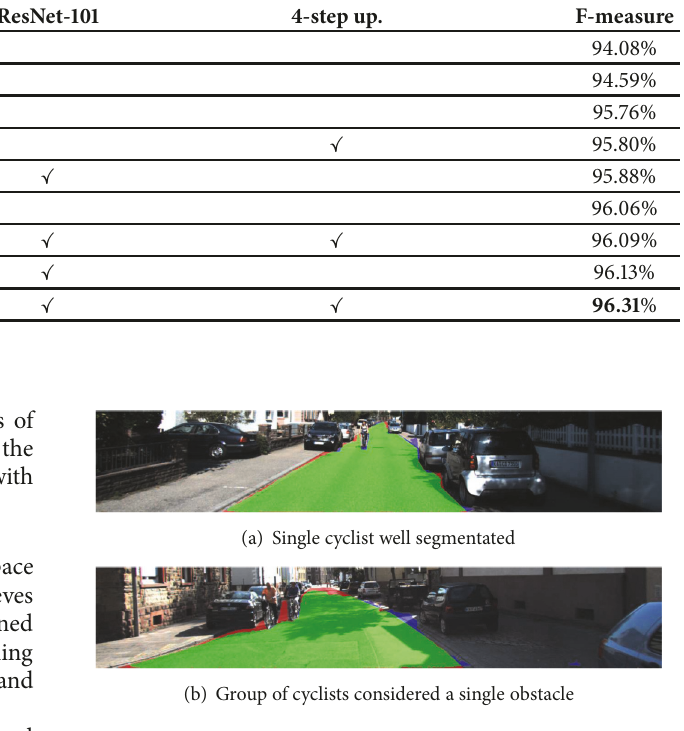
Figure 8: Results from the perspective-trained model in a scene with